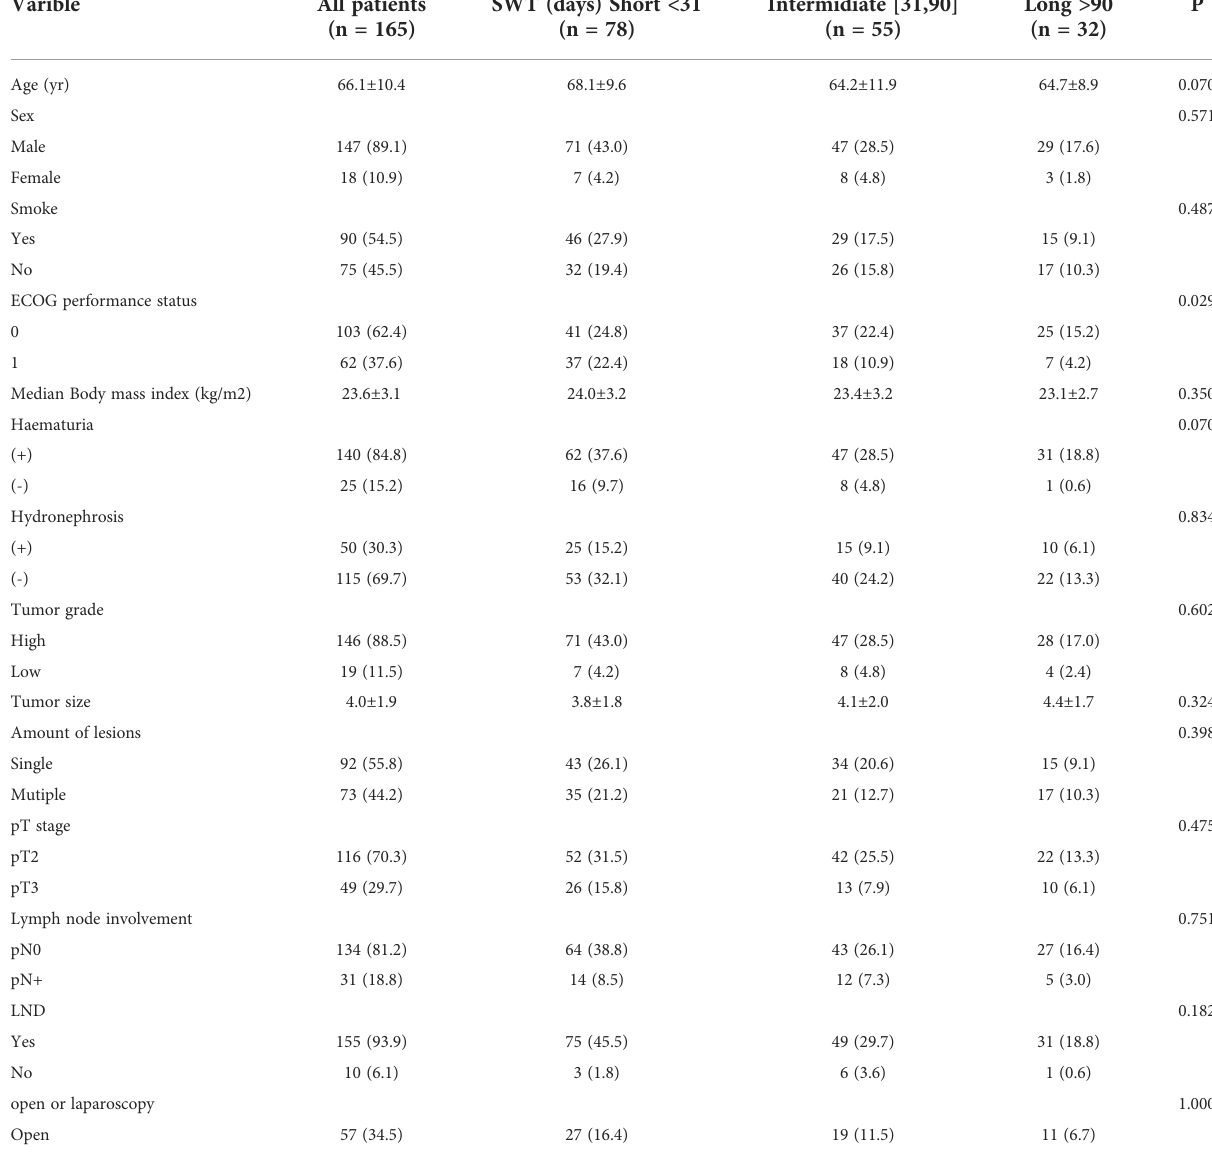
TABLE 1 Clinical characteristics of patients in three groups. Varible All patients